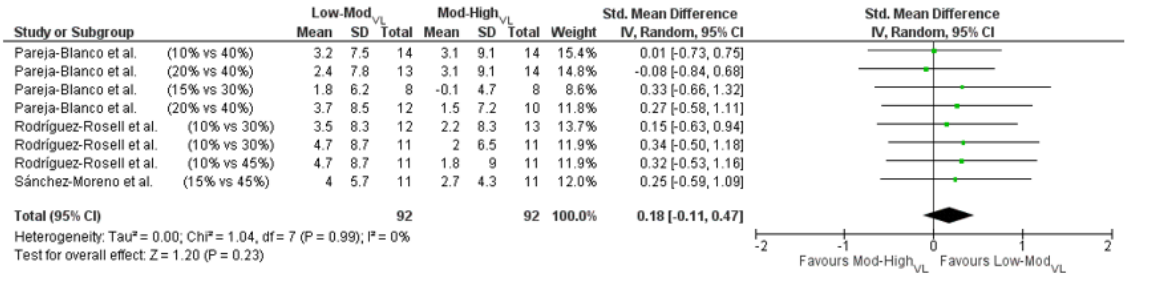
Figure 7. Between-group analysis comparing the effects of Low-Mod VL (≤25% intra -set VL) and Mod-High VL (>25% intra- set VL) to promote changes in jump capacity. Green squares: ES for each individual comparison; Black diamond: pooled ESs. Sánchez-Moreno et al. [31]; Pareja-Blanco et al. [35,37,38]; Rodríguez-Rosell et al. [34,40].